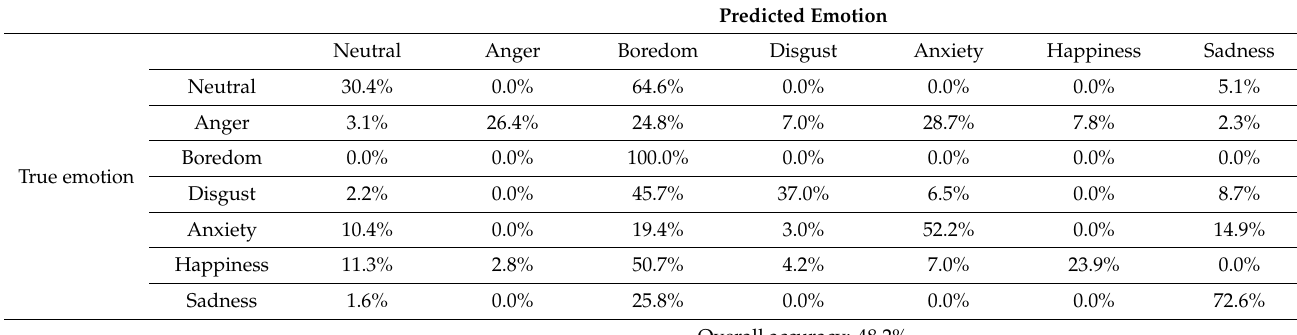
Table 10. Confusion matrix of the emotion classification results of the baseline CNN that was trained on the German EMO-DB mixed with the PCAFETER noise.